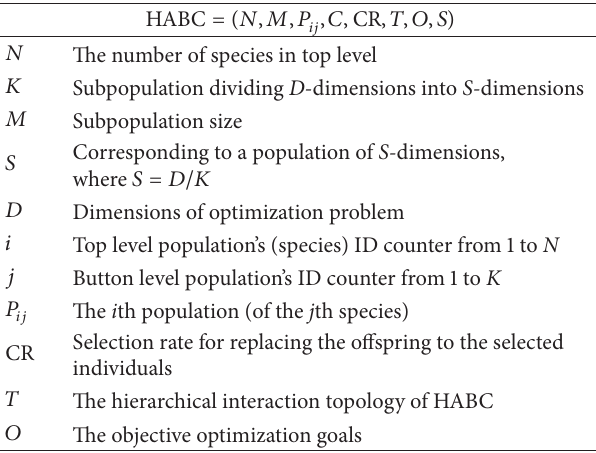
Table 2: Parameters of the